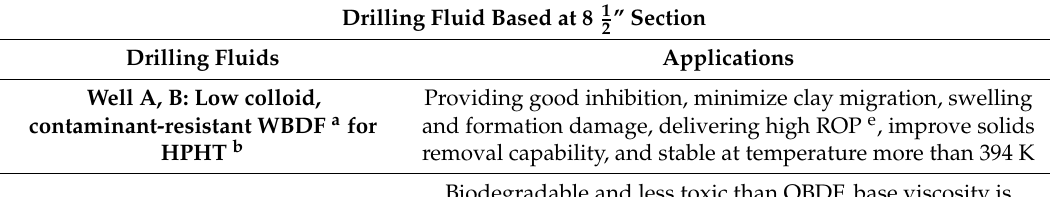
Table 12. Selection of drilling fluids and additives at 8 1